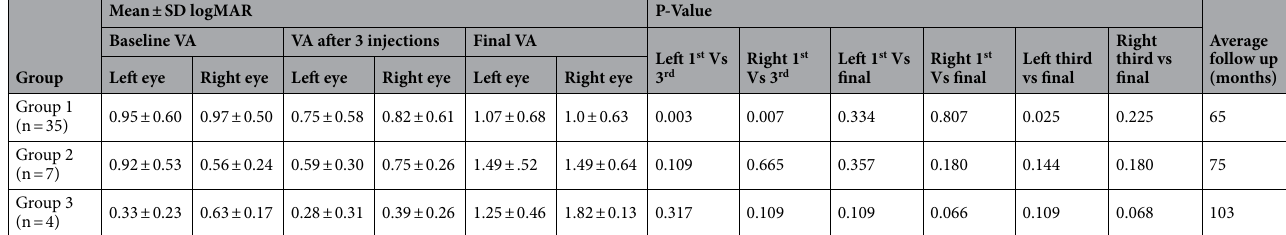
Table 6. Response of anti-VEGF treatment on visual acuity (logMAR) among different anti-VEGF groups of AMD patients ( i.e. group 1, 2 and 3) and total follow-up (in months) during the course of disease.